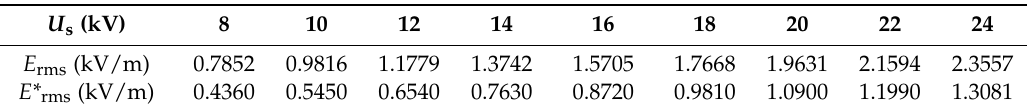
Table 3. Comparison of measured electric field values at point P before and after the approach of a human body (driven by different voltages).